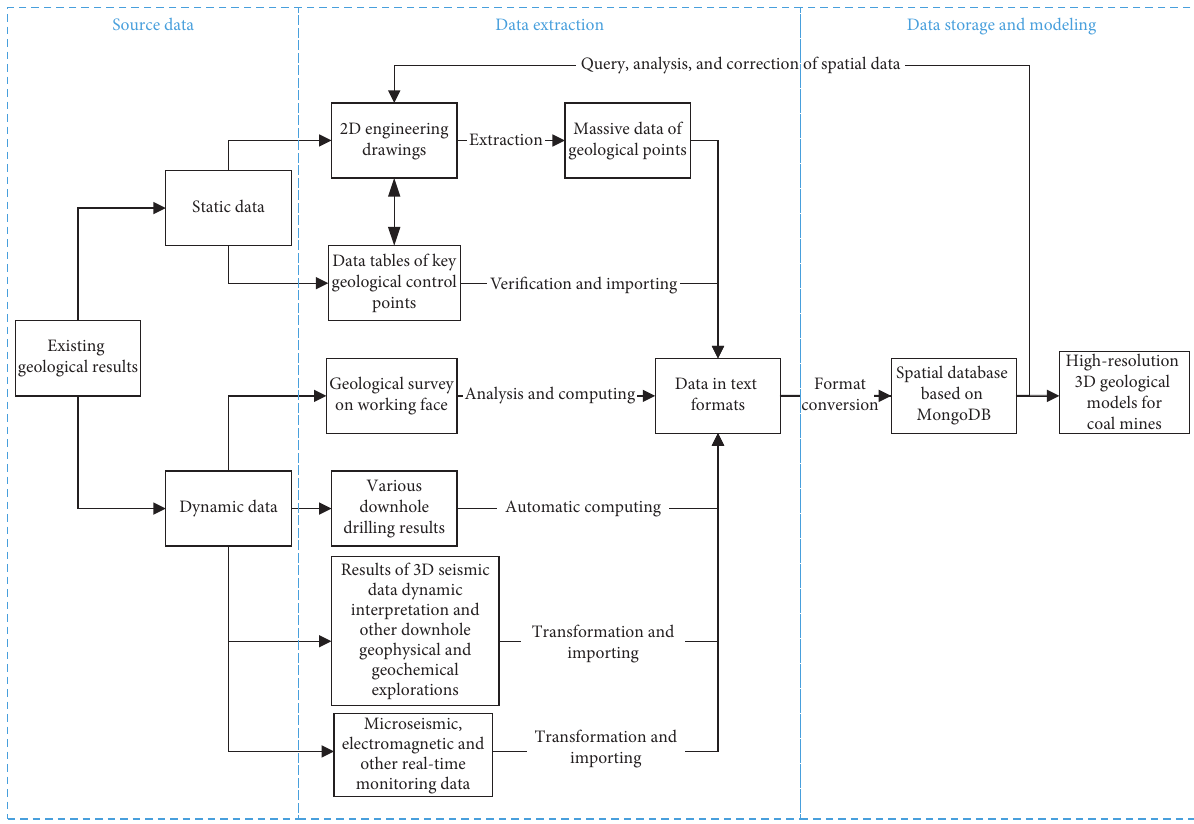
Figure 1: Flowchart of the process for building the basic geological database for coal mine